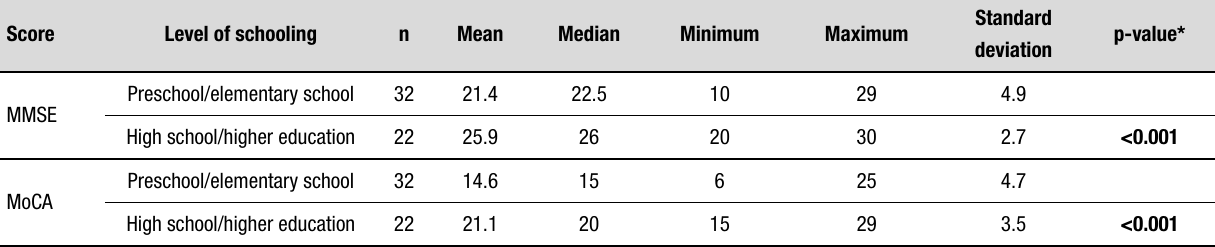
Table 3. Schooling × Mini Mental State Examination and Montreal Cognitive Assessment scores (n=54). Score